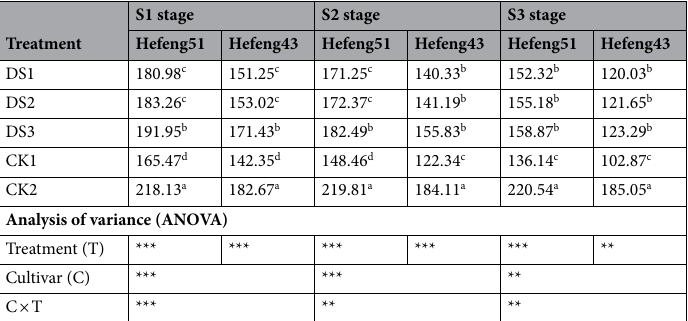
Table 5. Effects of foliar α-oxoglutarate and nitrogen on leaf GS activity under drought stress (µmol h −1 g −1 FW). Means with same letter within columns are not significantly different ( P < 0.05) using LSD test. ***, **Significance at 0.001, and 0.01, respectively.